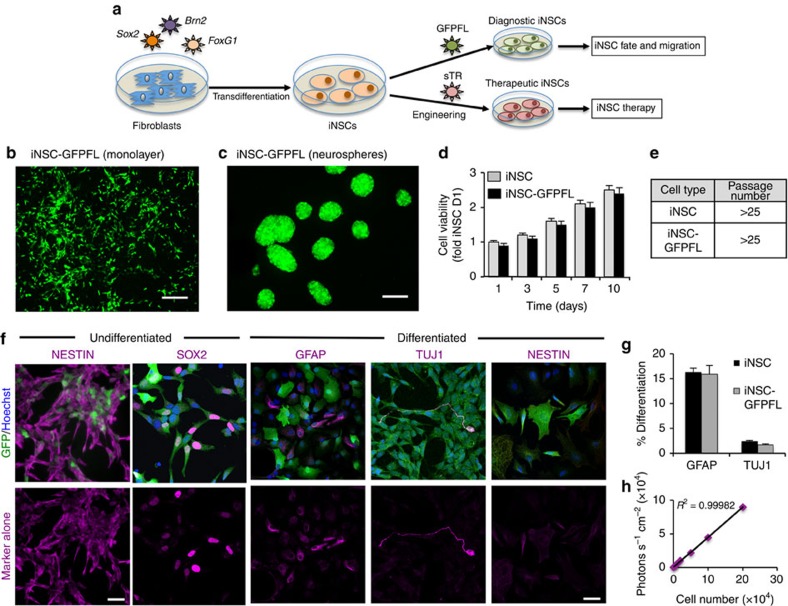
Generation and characterization of diagnostic and therapeutic iNSCs.(a) Schematic depiction of the strategy used to create therapeutic and diagnostic variants of iNSCs. (b,c) Representative fluorescent photomicrographs of iNSCs engineered to express GFPFL and grown as monolayers (b) or neurospheres (c). (d) Summary graph showing the growth of GFPFL-expressing iNSCs in comparison with unmodified iNSCs. (e) Summary table showing the maximum passage number of iNSCs expressing GFPFL and unmodified iNSCs. (f) Representative images of immunofluorescence that show the expression of the NSC markers nestin and Sox2 (staining shown in magenta) in iNSC-GFPFL (green). In addition, iNSC-GFPFLs were differentiated by mitogen removal and culturing for 12 days. The cells were stained to detect GFAP+ astrocytes, Tuj-1+ neurons and nestin (staining shown in magenta). Fluorescent images showing only the red (555 nm) secondary antibody channel are shown in the bottom row. (g) Quantification of GFAP+ or Tuj-1+ cells present after differentiation of iNSC-GFPFL or unmodified iNSCs. (h) Summary data showing the linear correlation between iNSC-GFPFL cell number and bioluminescence signal. iNSC-GFPFLs were plated at increasing cell numbers, combined with D-luciferin and were imaged in a luminometer (R2=0.99982). Scale bars in b,c, 100 and 20 μm in f. Data are mean±s.e.m. Data in d,e,g,h are from three to four independent experiments. In d, P>0.05 by two-way ANOVA.